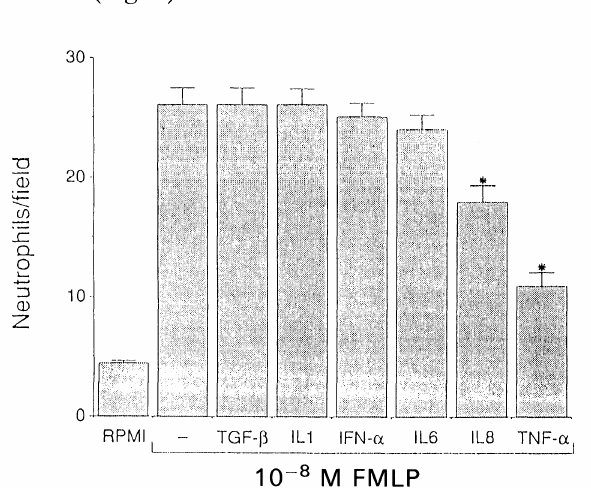
FIG. 1. Effects of cytokines on neutrophil chemotaxis induced by FMLP. The concentration of the cytokines was 10 -7 M. Results are reported as means +_ S.E.M. of the number of neutrophils per field. Average number of fields was 15 for each variable. (*p < 0.01, Student’s t-test.)